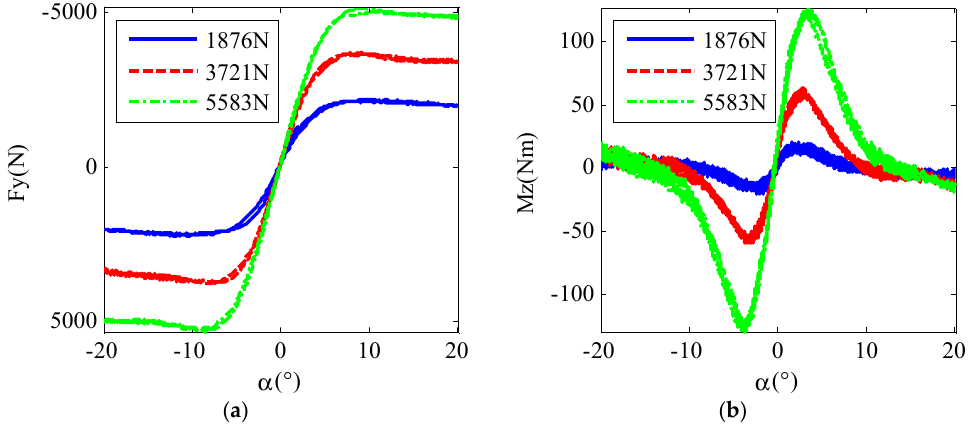
Figure 2. Row tire test data: ( a ) lateral force; ( b ) self-aligning torque.